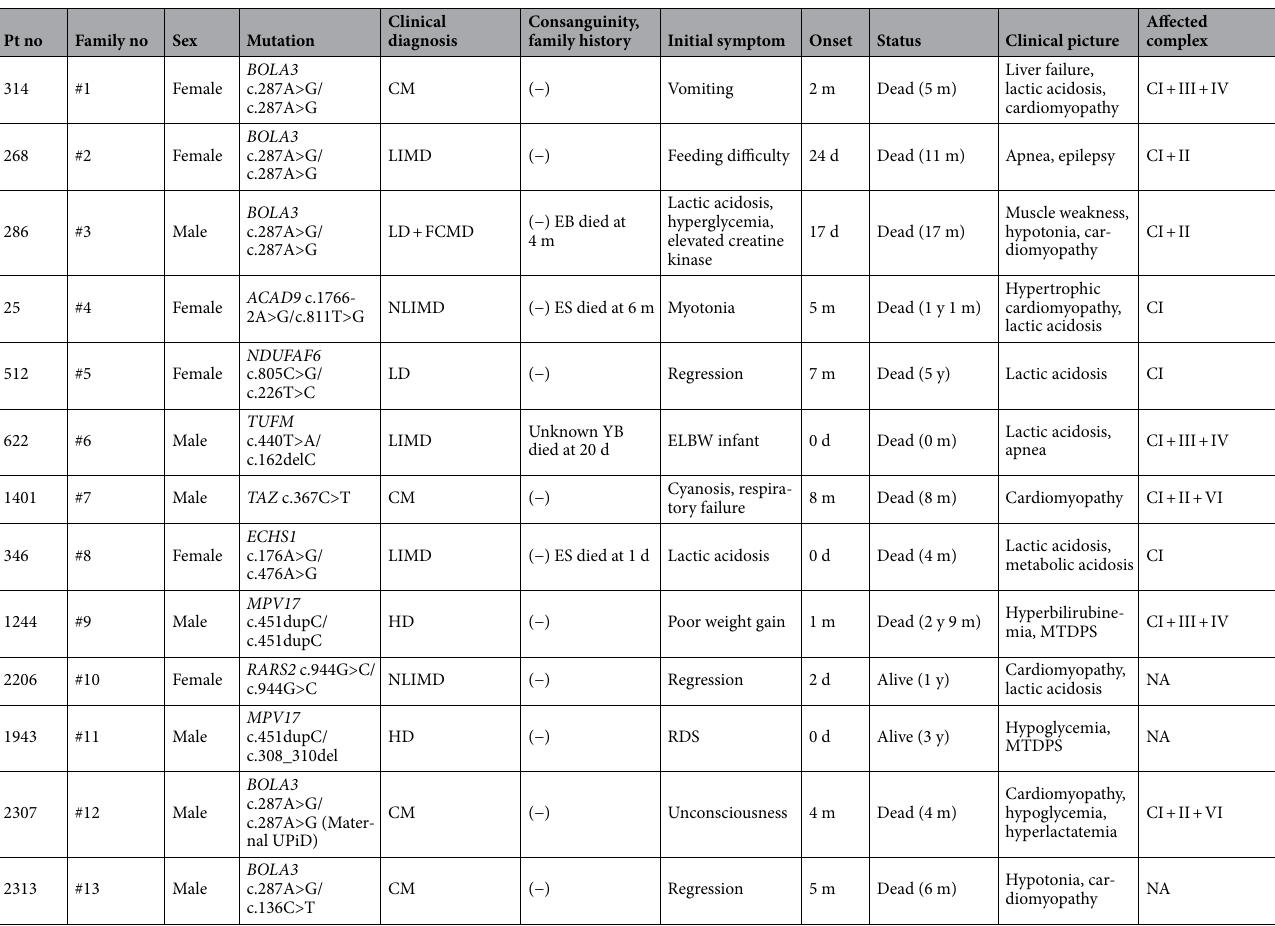
Table 1. Clinical characteristics of 13 probands. CM cardiomyopathy, LIMD lethal infantile mitochondrial disease, NLIMD nonlethal infantile mitochondrial disease, LD Leigh disease, FCMD Fukuyama